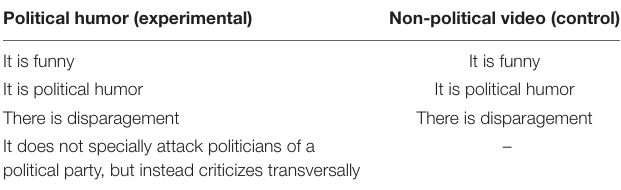
TABLE 2 | Statements presented to assess stimuli